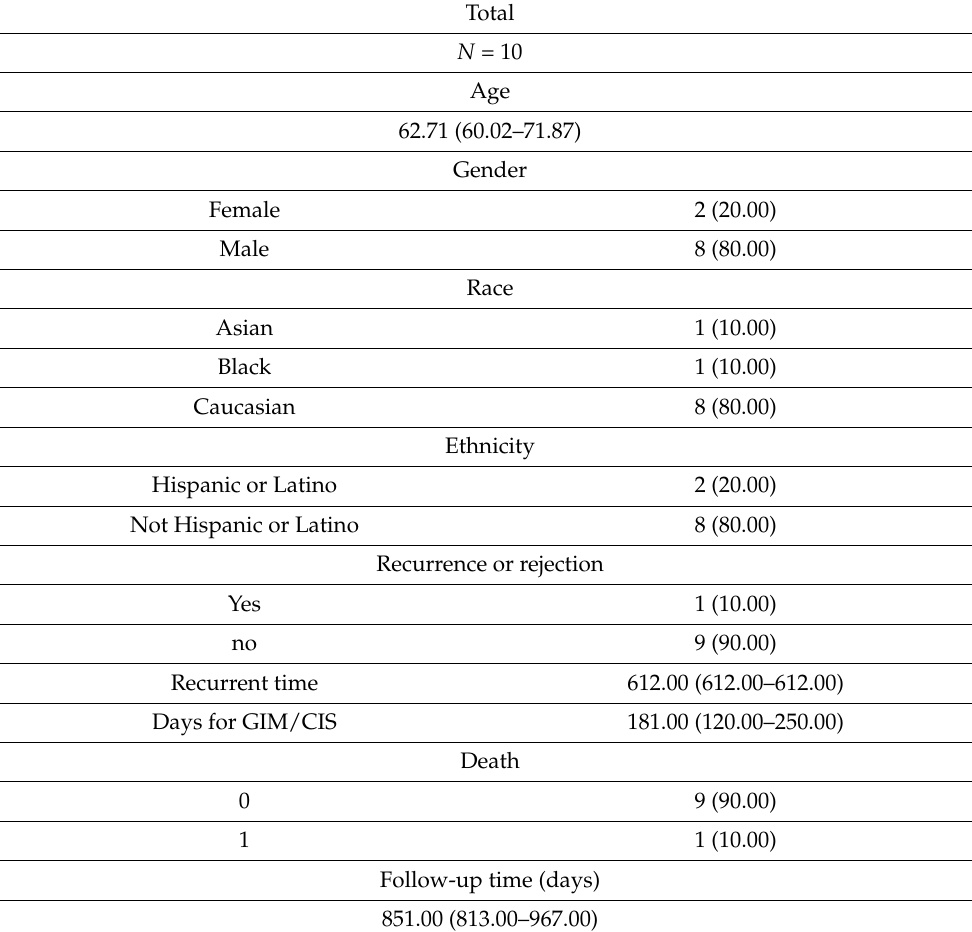
Table 2. Transplant-related outcomes in patients who received Gemcitabine plus Cisplatin as a neo- adjuvant treatment for cholangiocarcinoma prior to liver transplantation; data were presented as median (25th percentile–75th percentile) for continuous variables and number (%) for categorical variables. The Basic Characteristics of the Included Patients Who Received Gemcitabine Plus Cisplatin as a Neo-Adjuvant Treatment for Cholangiocarcinoma Prior to Liver